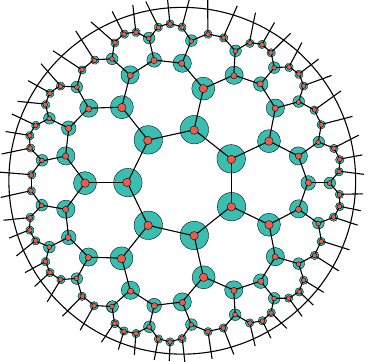
Figure 5: An example tensor network. The blue circles each represent tensors, four- partite states on the union of the small red circle and three black legs touching that blue circle. Each tensor can be viewed as a map from a state on the red circle to a state on the black legs. A solid black line between tensors represents postselection of the state on one leg from each tensor onto the state | MAX 〉 . The entire tensor network forms a map from states on the union of the small red circles to the union of the boundary legs, which are those legs crossing the outer